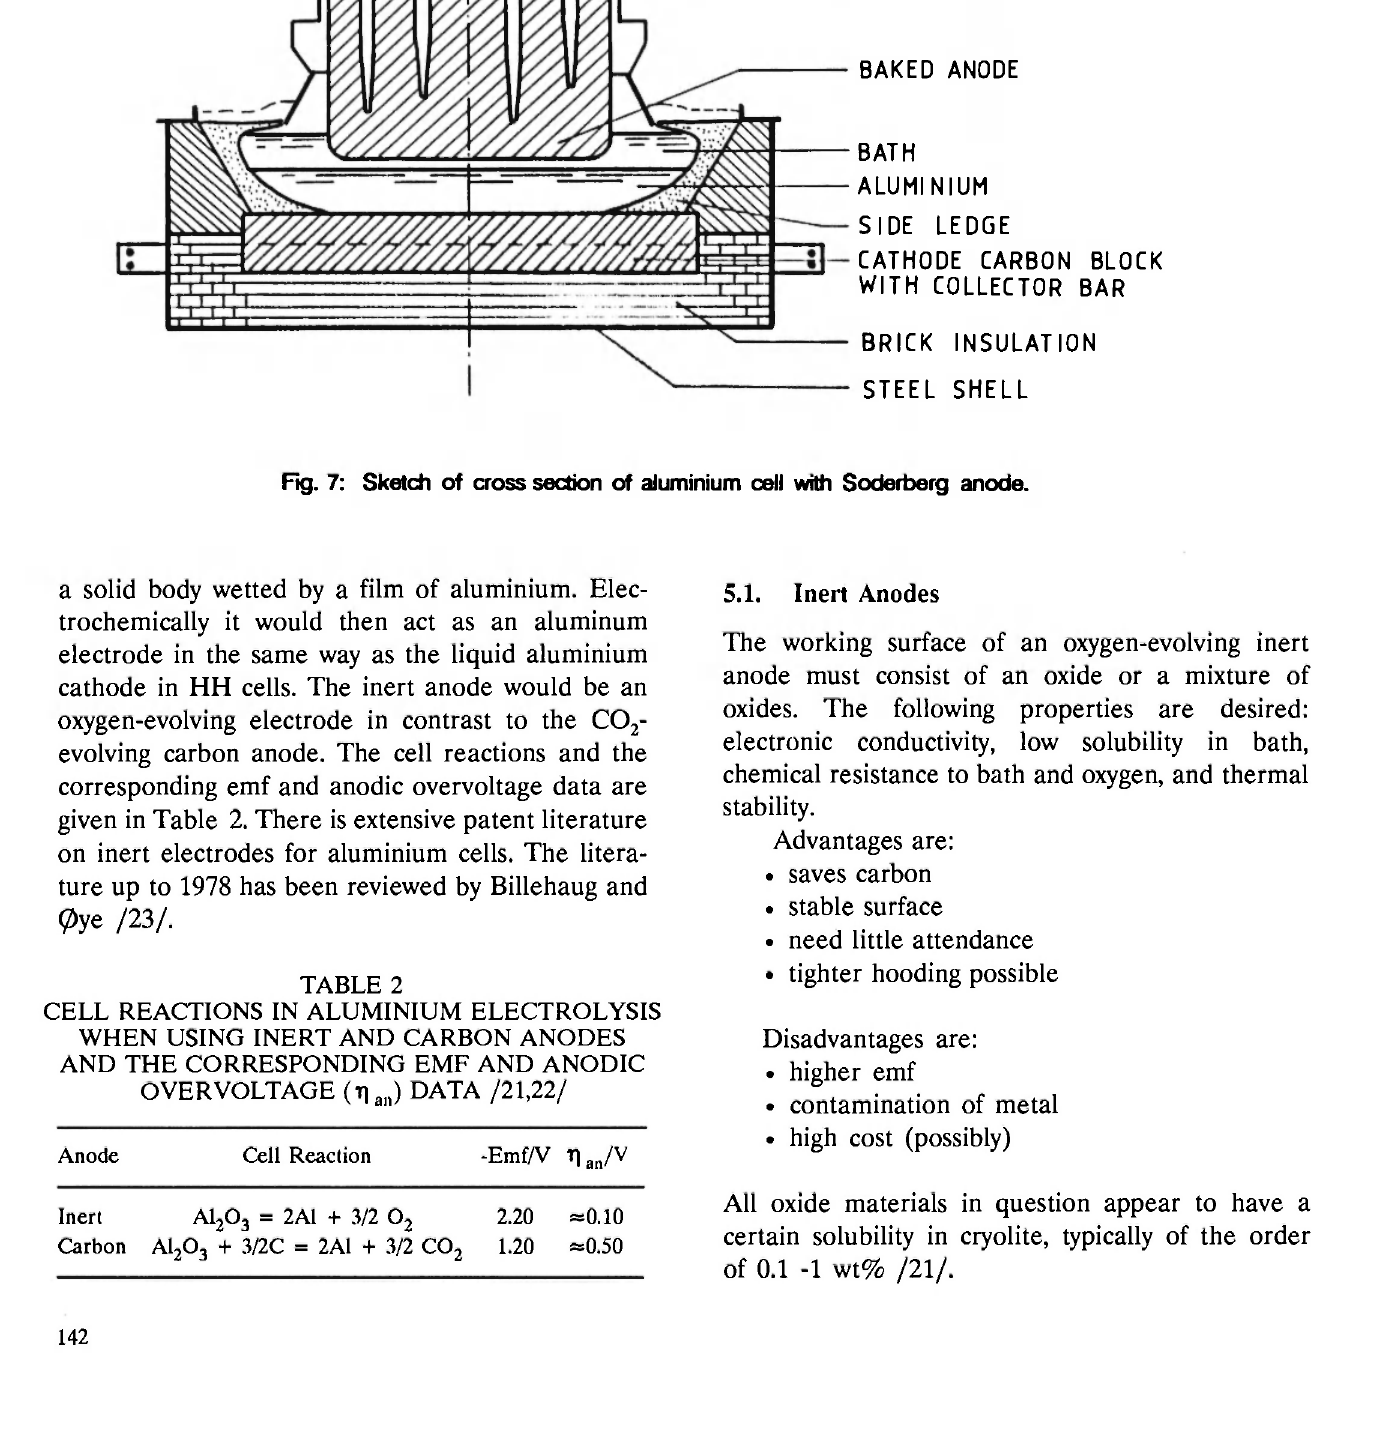
CELL REACTIONS IN ALUMINIUM ELECTROLYSIS WHEN USING INERT AND CARBON ANODES AND THE CORRESPONDING EMF AND ANODIC OVERVOLTAGE (η ) DATA 3η